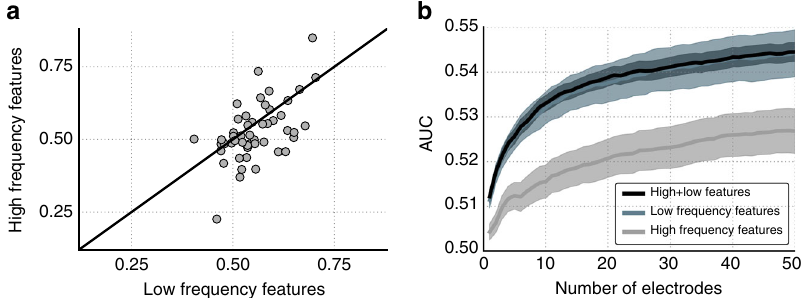
Fig. 7 Logistic regression classi fi cation of subsequent memory success. a Area under the ROC curve (AUC) computed using either a classi fi er trained only low-frequency (1 – 10 Hz) or high-frequency (40 – 100 Hz) features. Each point represents the AUC for one subject ( N = 50). b AUC as a function of the number of electrodes used to train the classi fi er, plotted separately for low-frequency features (blue line), high-frequency features (grey), and combined low-frequency and high-frequency features (black). Shaded errors regions are within-subject standard errors